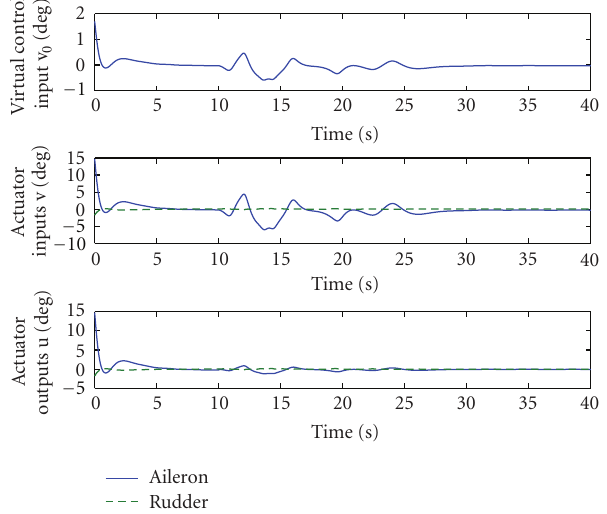
Figure 3: Time history of control signals and actuator outputs (Case